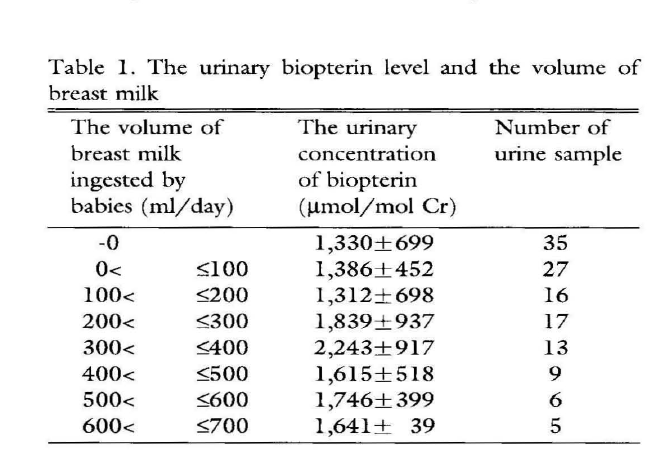
Table 1. The urinary biopterin level and the volume of breast